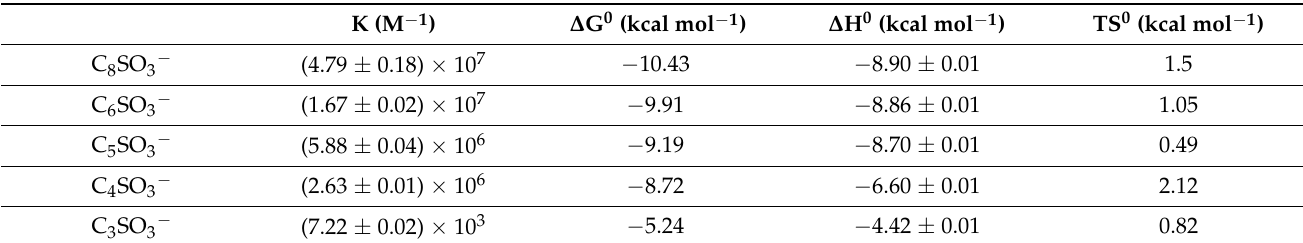
Table 2. Thermodynamic parameters obtained for host:guest complexes between pillararene and different